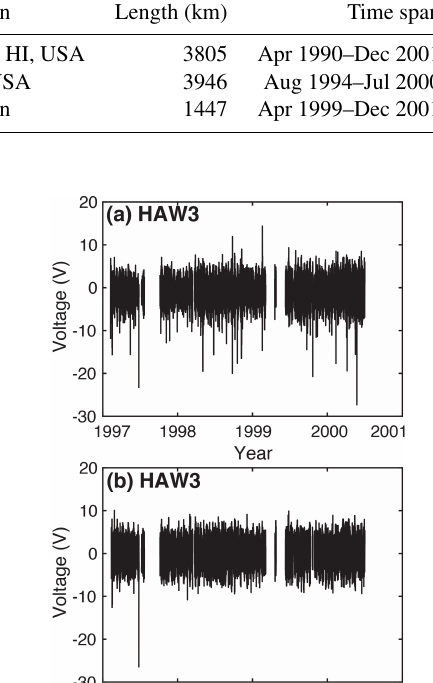
Table 1. The seafloor voltage cables used in this study. The HAW1N and HAW1S cables run parallel to each other. Cable Starting location Ending location Length (km) Time span HAW1N and HAW1S Point Arena, CA, USA HAW3 OKI